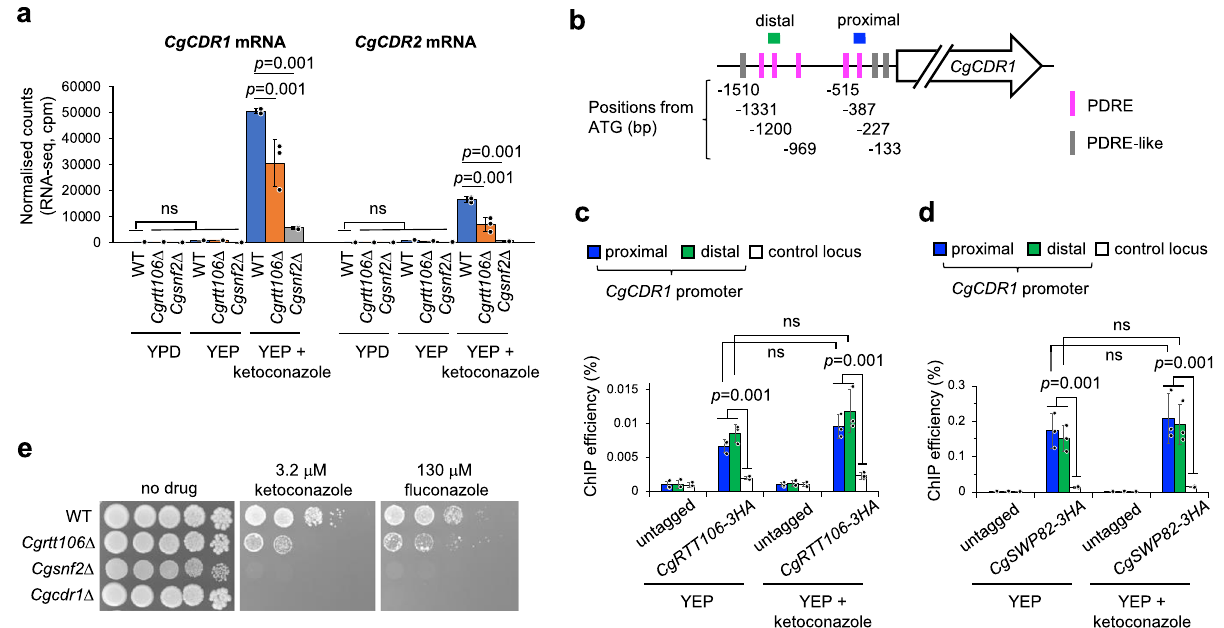
Fig. 7 CgRtt106 and CgSWI/SNF mediate antifungal resistance by upregulating expression of the multidrug transporter genes in C. glabrata . a RNA- seq analysis reveals reduction of mRNA of multidrug transporter genes CgCDR1 and CgCDR2 in the absence of CgRtt106 and CgSnf2 upon transient ketoconazole treatment in YEP. Data represents mean of three biological replicates. Signi fi cance determined by one-way ANOVA with post-hoc Tukey HSD test. ns, P > 0.05. b Positions of PDRE and PDRE-like motif in the CgCDR1 promoter. c , d ChIP-qPCR analyses of CgRtt106 ( c ) and the CgSwp82 SWI/ SNF subunit ( d ) at the CgCDR1 promoter in YEP with and without ketoconazole. Proximal (blue) and distal (green) PDRE sites (illustrated in b ) were analysed. Control locus (white) is coding region of the CgADY3 gene. Data represent mean of three biological replicates. Signi fi cance determined by one- way ANOVA with post-hoc Tukey HSD test. ns, P > 0.05. e Sensitivity to azole antifungal drugs of the C. glabrata reference strain (ATCC 2001) and C. glabrata lacking CgRtt106, CgSnf2 or CgCdr1. Five-fold dilutions of cell culture were spotted on YPD or YPD containing ketoconazole or fl uconazole, and incubated at 30 °C for 2 – 3